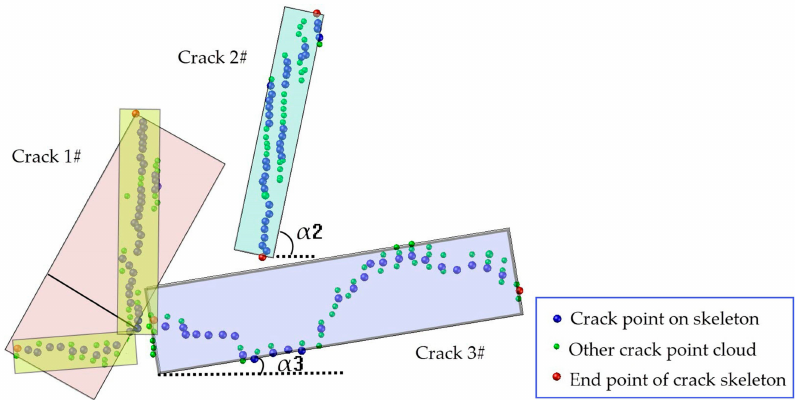
Figure 10. The judgment of the crack